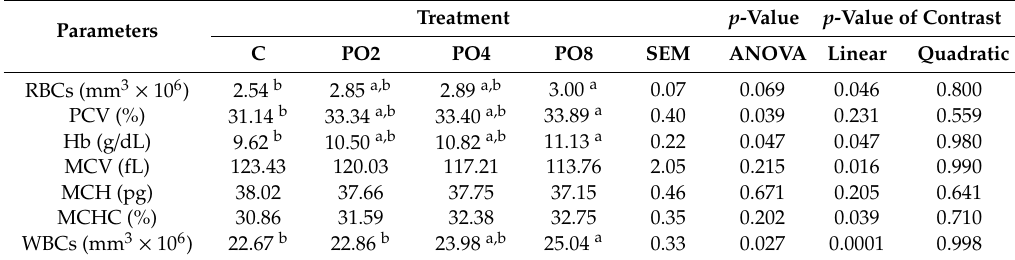
Table 4. Haematological blood indicators of broilers fed on di ff erent supplementation doses of POLM at day